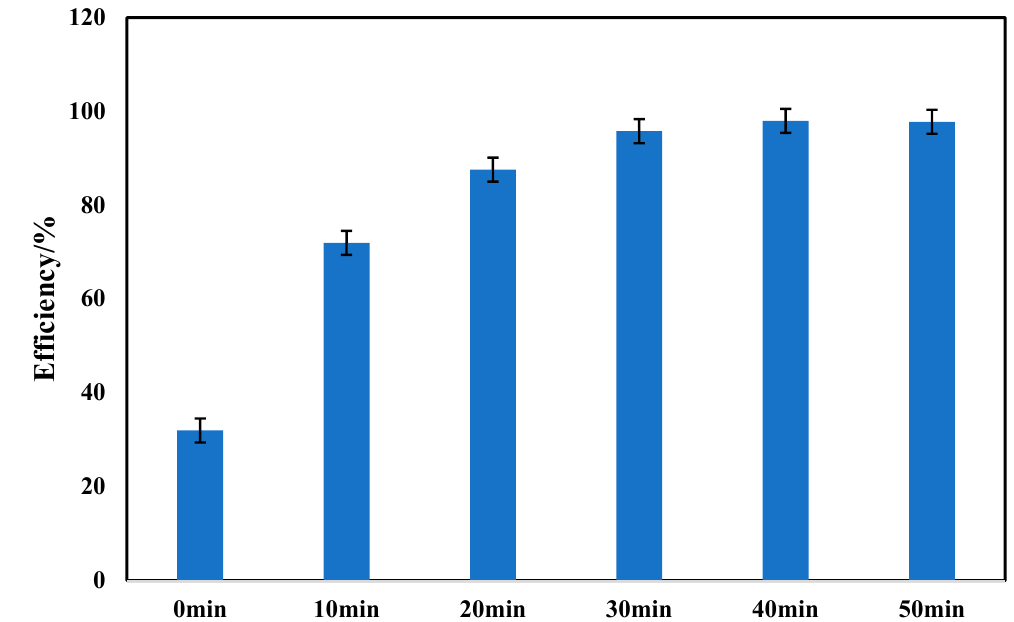
Figure 4. Metal ions elimination e ffi ciency vs. cathodic polarization time. Graphite carbon rods were used as working and auxiliary electrode, Ag / AgCl electrode as the electrical reference electrode, polarized potential was − 0.1 V vs. Ag / AgCl.